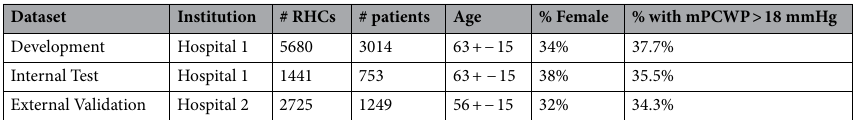
Table 1. Dataset summary statistics.